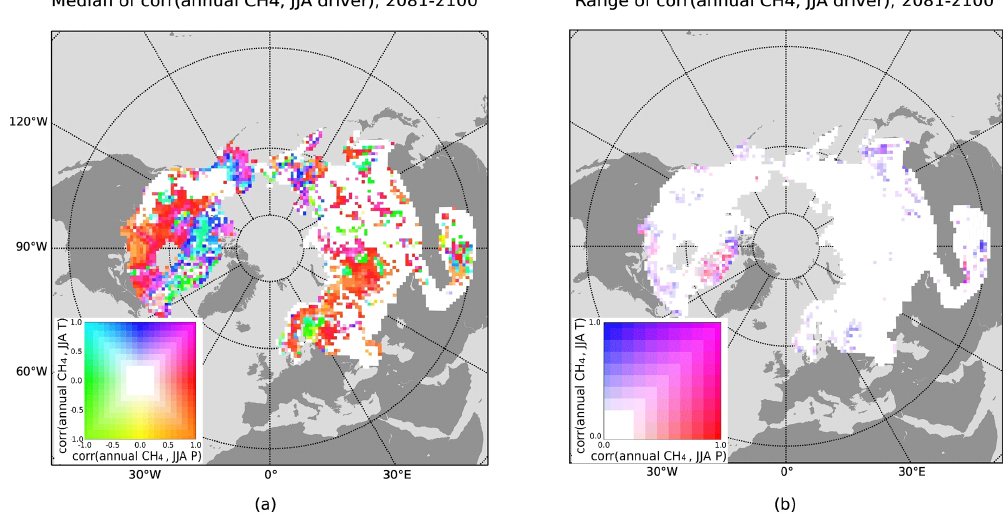
Figure 12. Spatial distributions of ensemble median (left) and range at 95% confidence level (right) of correlations between annual CH 4 emissions and JJA T and P for the period 2081–2100 of the sensitivity-based projection. The green-red and yellow-blue axes depict the strength of correlation ( − 1 to 1) with JJA P and JJA T ,